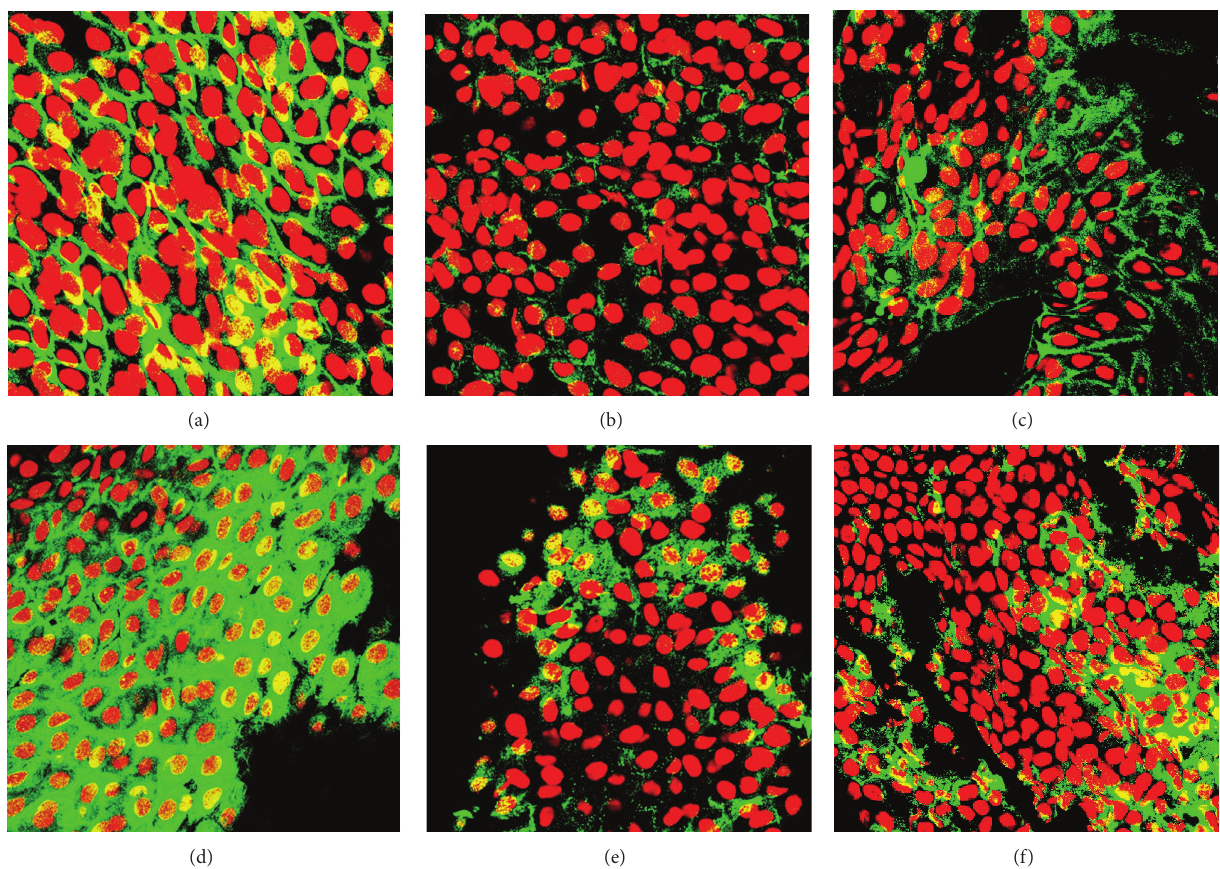
Figure 3: Immunofluorescence staining of impression cytology. (a–c) Cytoplasmic MMP9 staining in conjunctival cells at baseline (a) and its significant reduction observed after 90 days of Optive (b) and Hylogel (c) therapy. (d–f) Expression of IL6 in conjunctival cells at day 0 (d) and its downmodulation at the end of the treatment in Optive (e) and Hylogel (f) groups. Original magnification ×